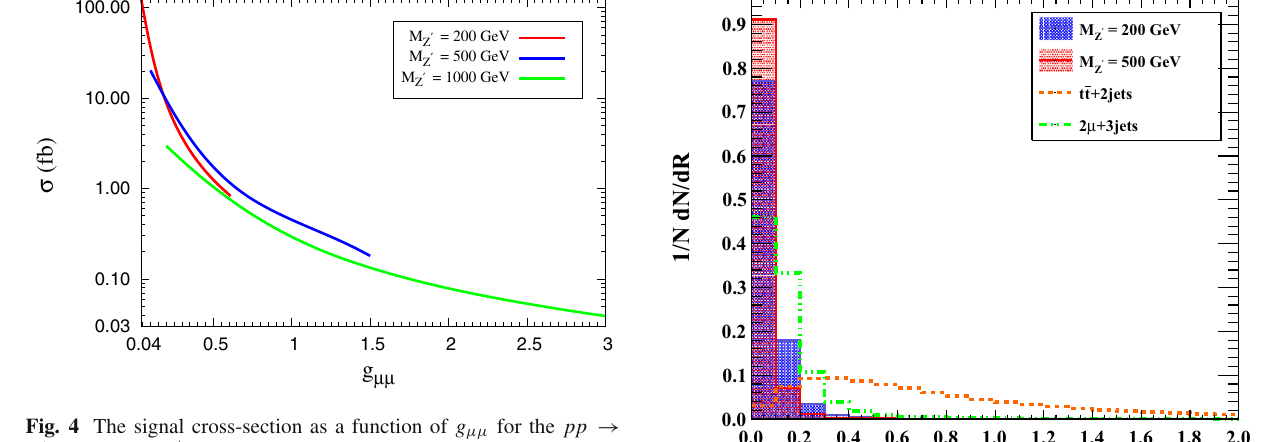
Fig. 4 The signal cross-section as a function of g μμ for the pp → Z (cid:2) + 1 b ( 2 b ) → μ + μ − + 1 b ( 2 b ) process.Weshowtheresultsfor M Z (cid:2) = √ s = 14 TeV. Each curve is plotted for the 200, 500 and 1000 GeV at corresponding g μμ range taken from Table 1, which is determined by flavor and trident constraints the leading ( μ 1 ) and sub-leading ( μ 2 ) muons are contrasted between the signal and the background. We find that cutting on p T (μ 1 ) > 90 GeV, and p T (μ 2 ) > 50 GeV allows us to